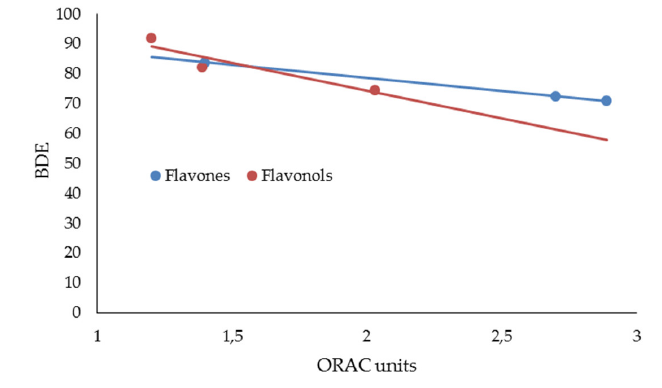
Figure 4. Relationships between the oxygen radical absorbance capacity (ORAC) and binding dissociation enthalpy (BDE) values for flavonols and flavones.